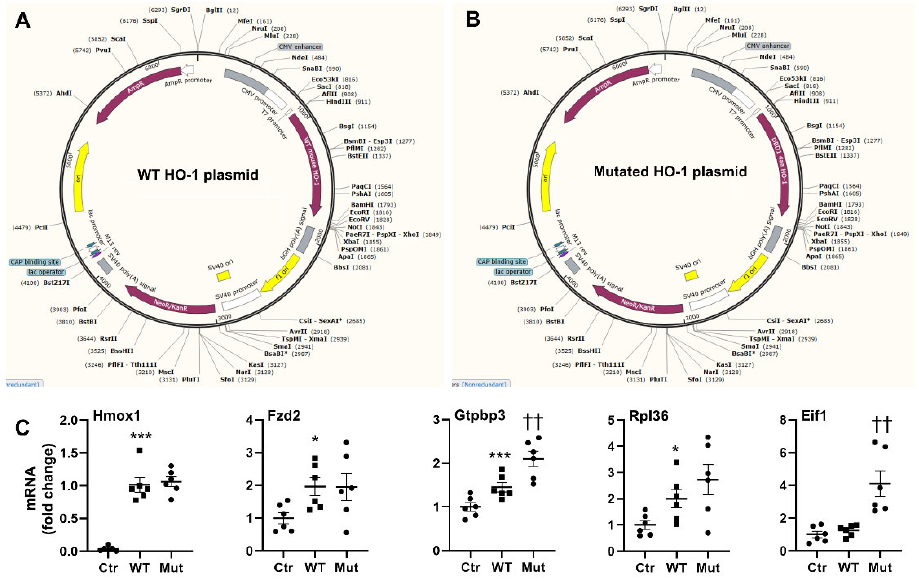
Figure 7. Mutation of amino acids in HO-1 DBD1 alters target gene expression. ( A , B ) Construction of WT and mutated HO-1 plasmids. In mutated plasmids, four conserved amino acids (E215, I211, E201, and Q27) within the HO-1 DBD1 were mutated to alanine. ( C ) Gene expression was measured by qRT-PCR in Hmox1 deficient MLE-12 cells transfected with WT and mutated (Mut) HO-1 plasmids, or control without plasmids (Ctr). Data are expressed as mean ± SEM. N = 6. * p < 0.05, *** p < 0.001 vs. Ctr group, †† p < 0.01 vs. WT group.